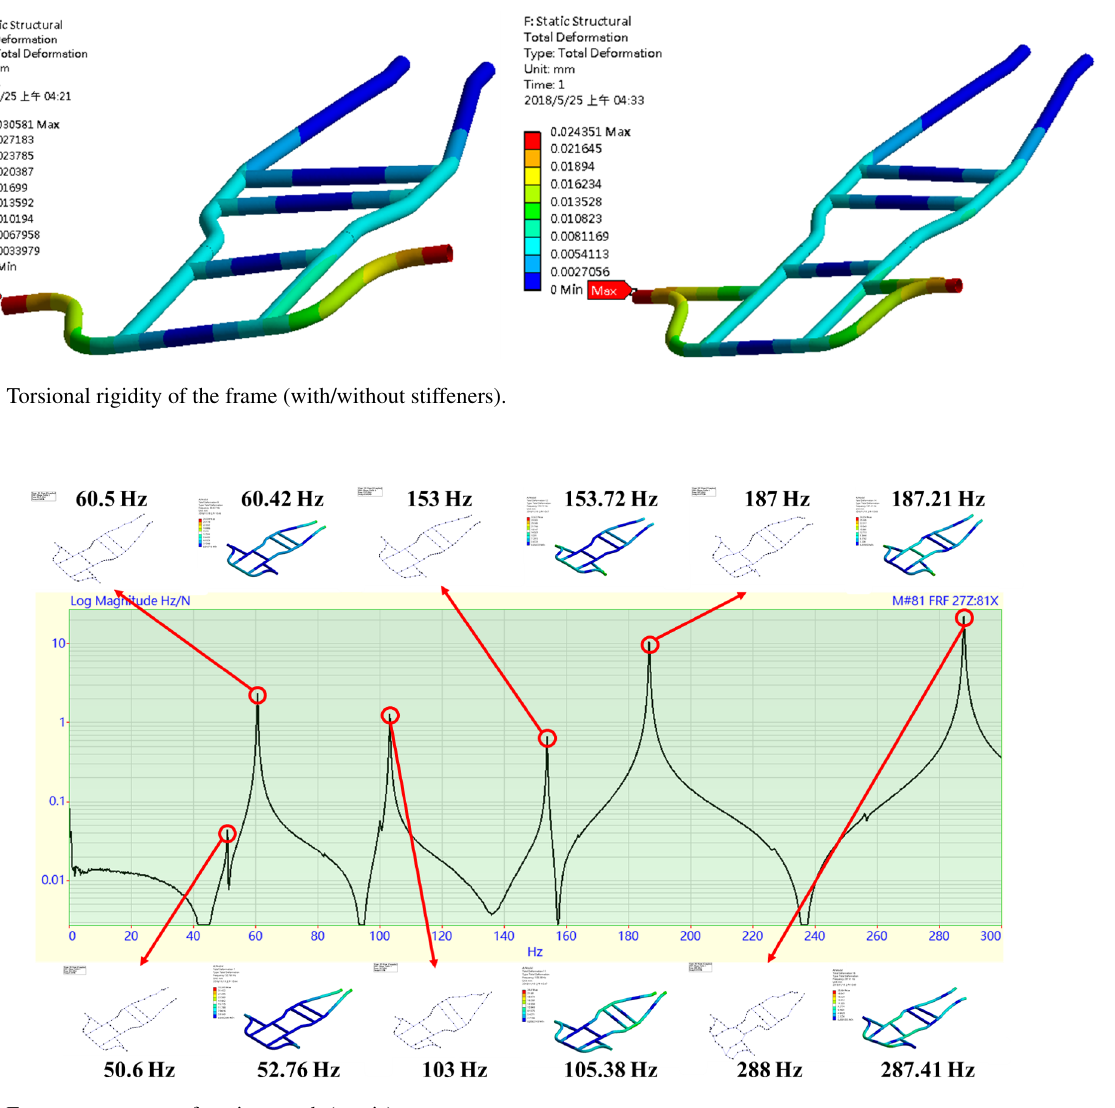
Figure 34. Frequency response function graph ( z